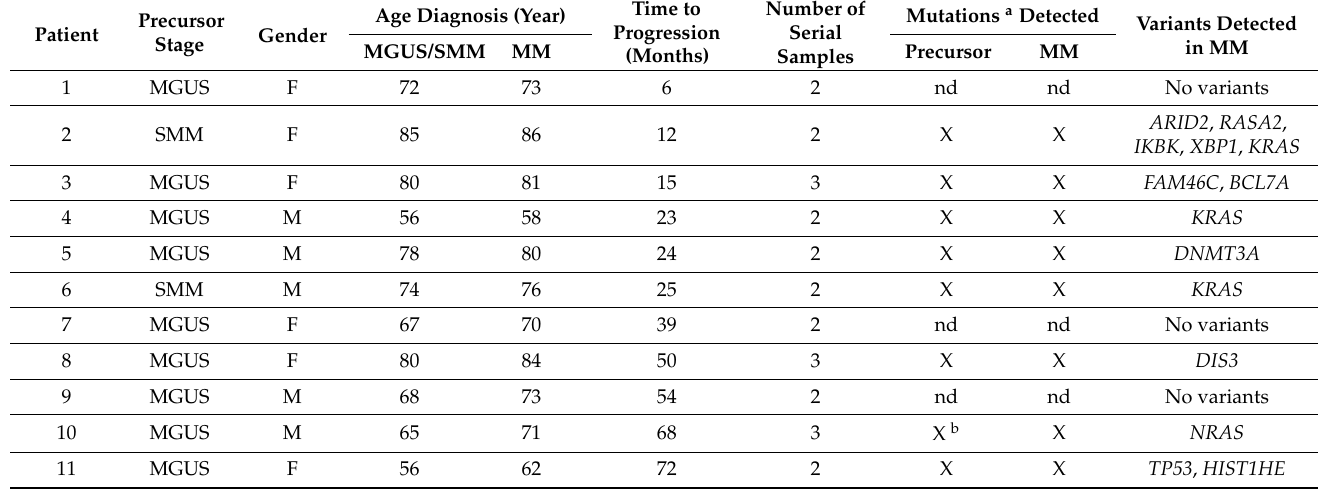
Table 1. Patients, their characteristics and detected variants. All 21 patients with at least two serial BM smears were sequenced with the targeted panel including 81 myeloma-related genes. In this table, the precursor stage, gender, age of diagnosis (years), time to progression (months), serial samples and detected variants are shown for all